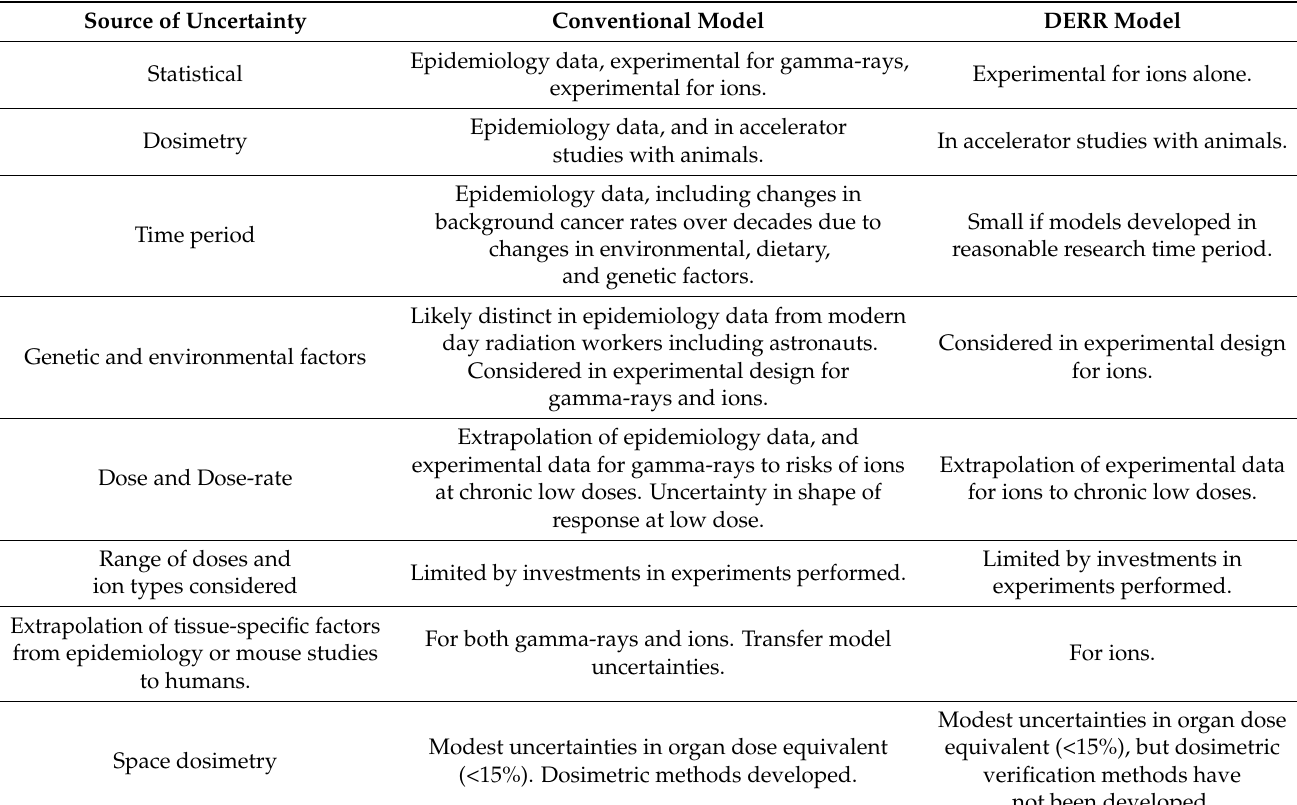
Table 1. Comparisons of sources of uncertainty in the conventional model to the DERR